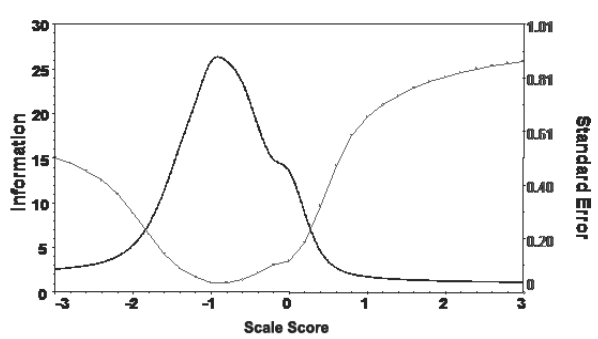
Figure 4 – Item Information and measurement error curve (3rd